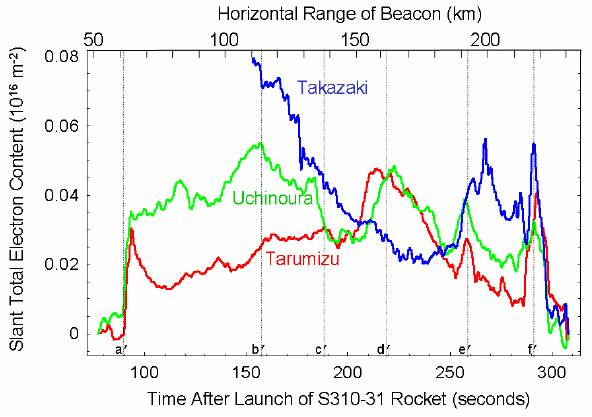
Fig. 3. TEC data from the DBB instrument on the first SEEK-2 rocket launched on 3 August 2002 at 14:24 GMT. The (a) Tarumizu and (b) Uchinoura data are recorded near the plane of the rocket trajectory. The (c) Takazaki data is obtained from a receiver 66km away from this